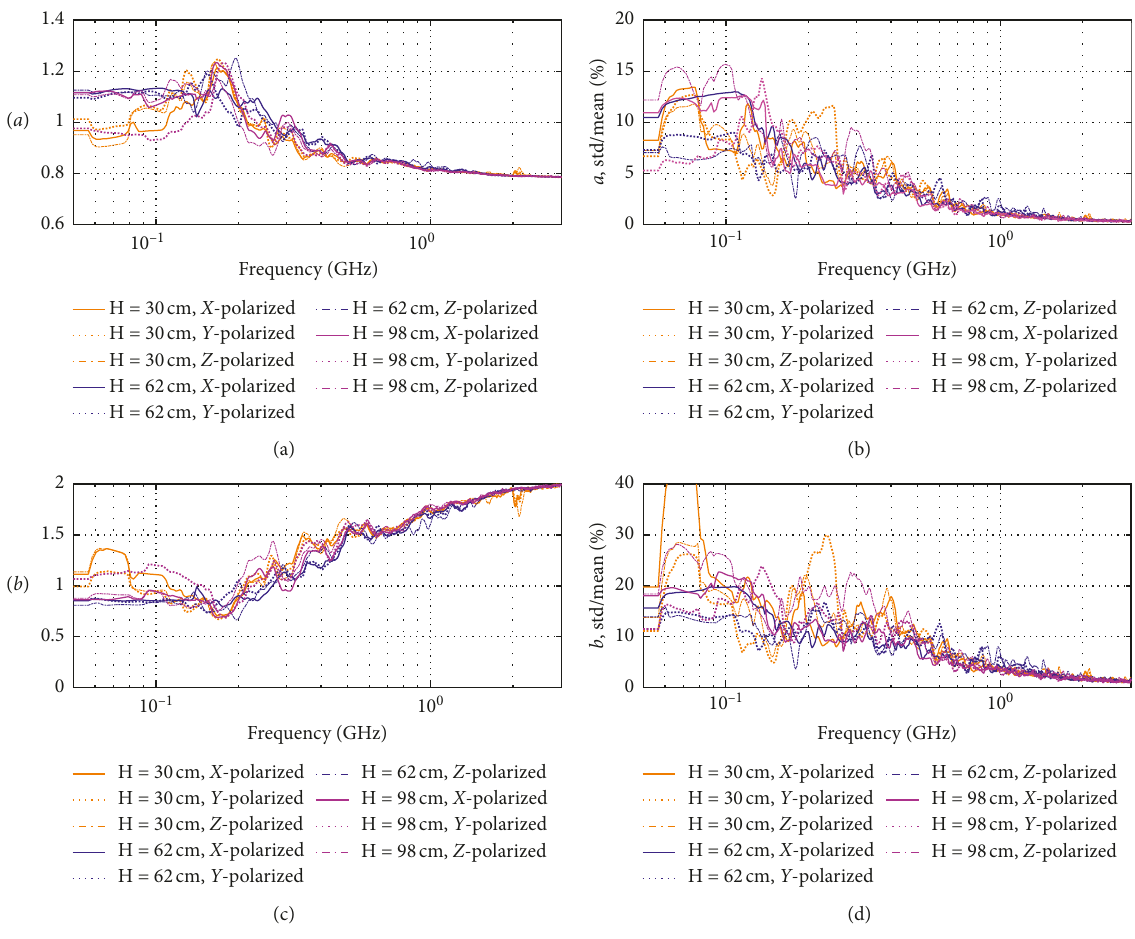
Figure 3: Mean values and the relative standard deviation (in percentage) of the estimated ( a,b ) at different heights and polarizations.